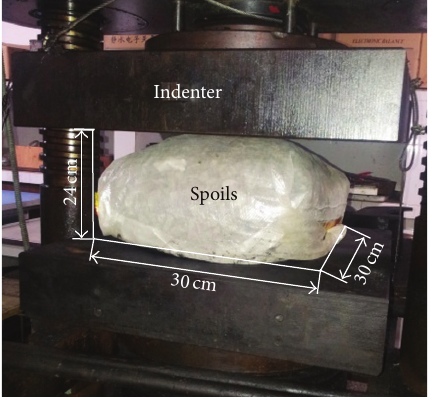
Figure 6: Unconfined compressing experiment of spoils.